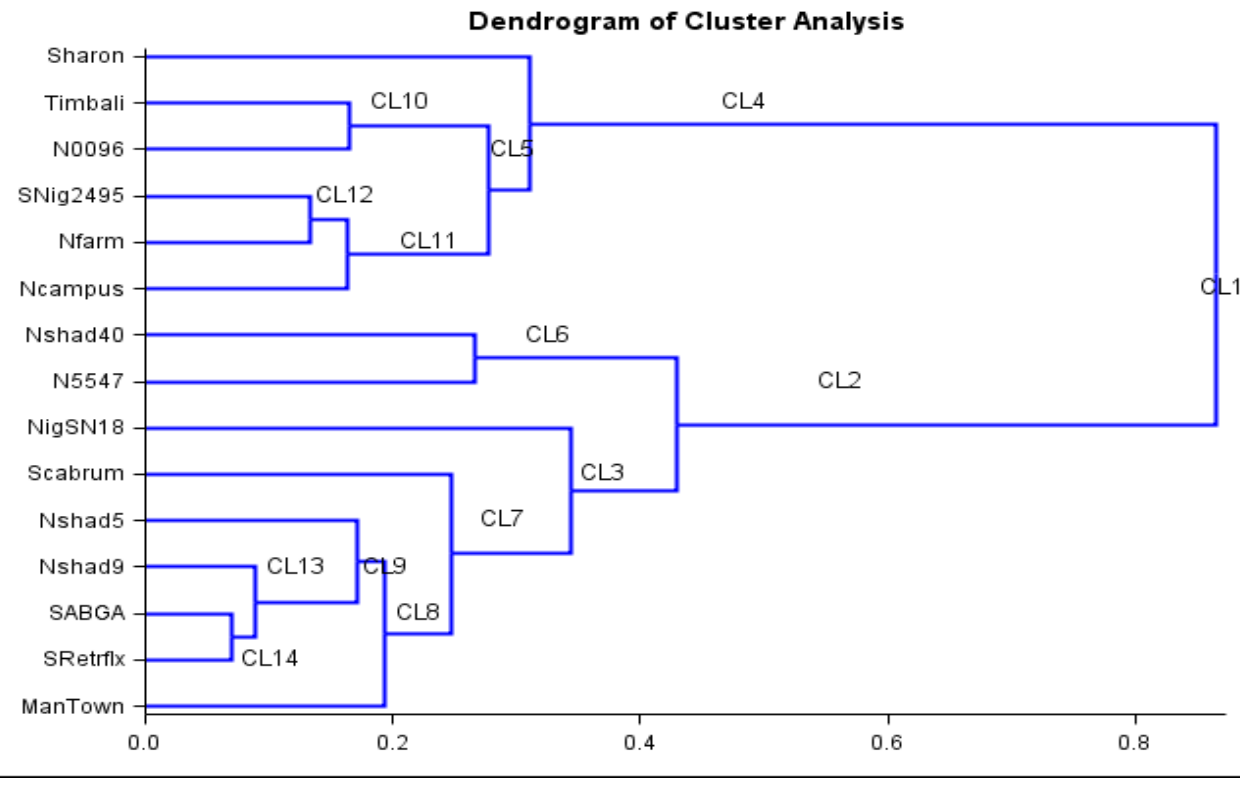
Figure 2. Cluster analysis showing phenotypic association among nightshade accessions. CL—cluster.